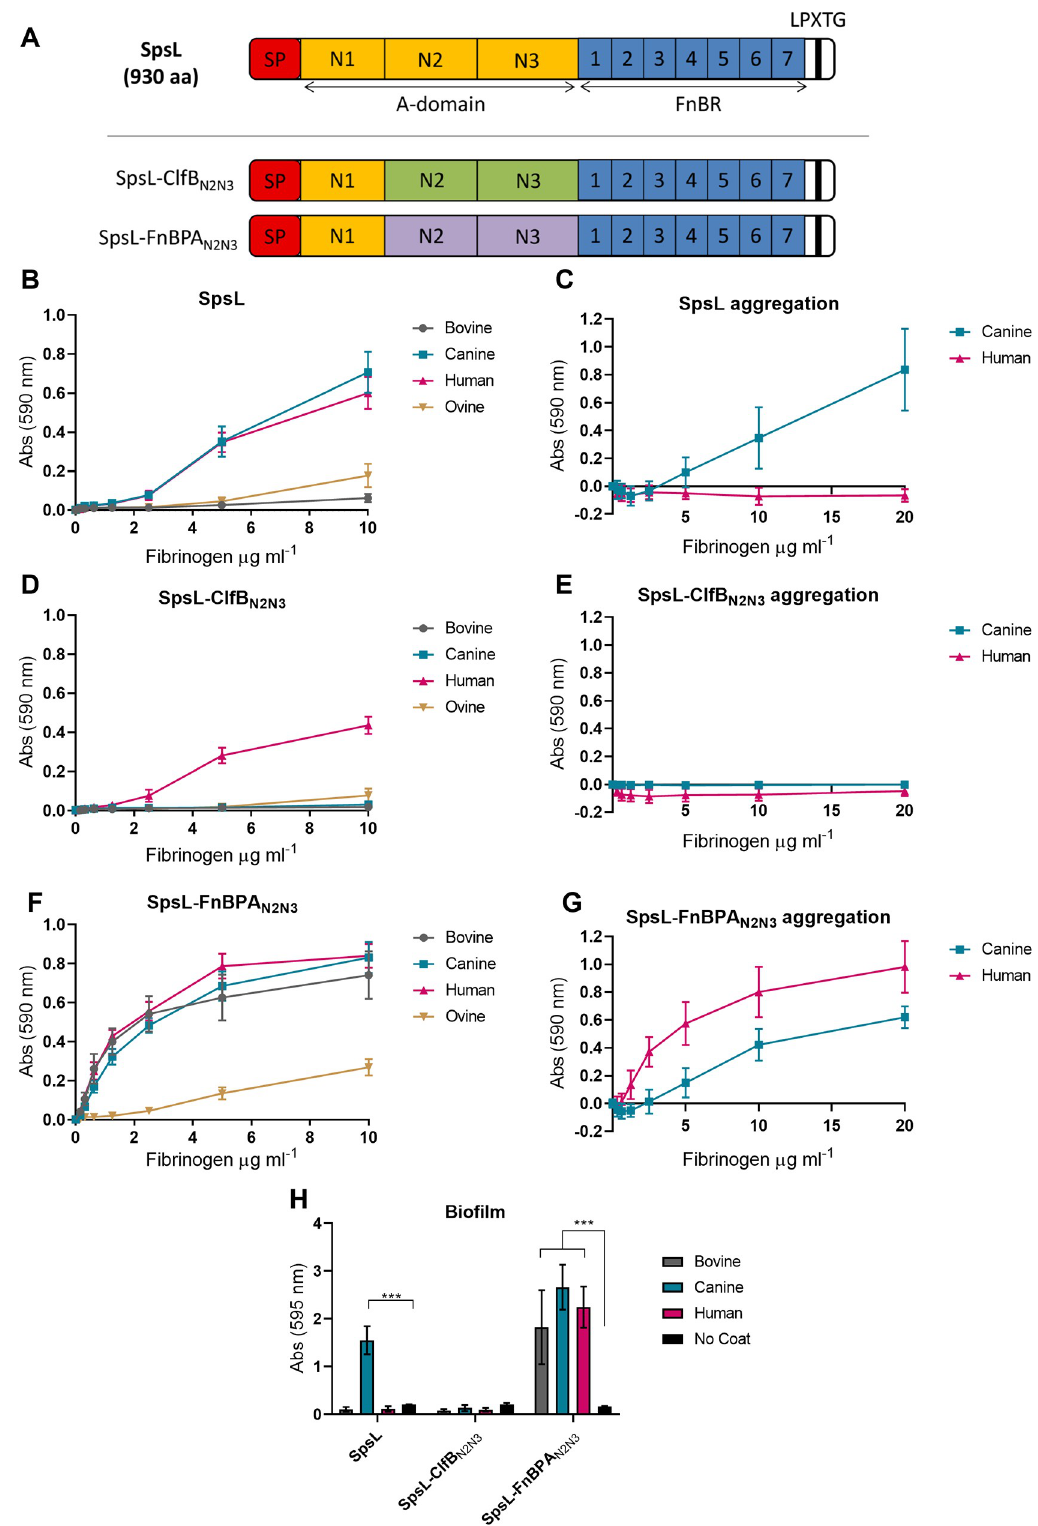
Fig 6. SpsL promotes bacterial aggregation and biofilm formation in a host-restricted manner. (A) Schematic of the SpsL chimeric cell wall-associated truncates generated. Bacterial adherence assays of full length SpsL (B), chimeric SpsL-ClfB N2N3